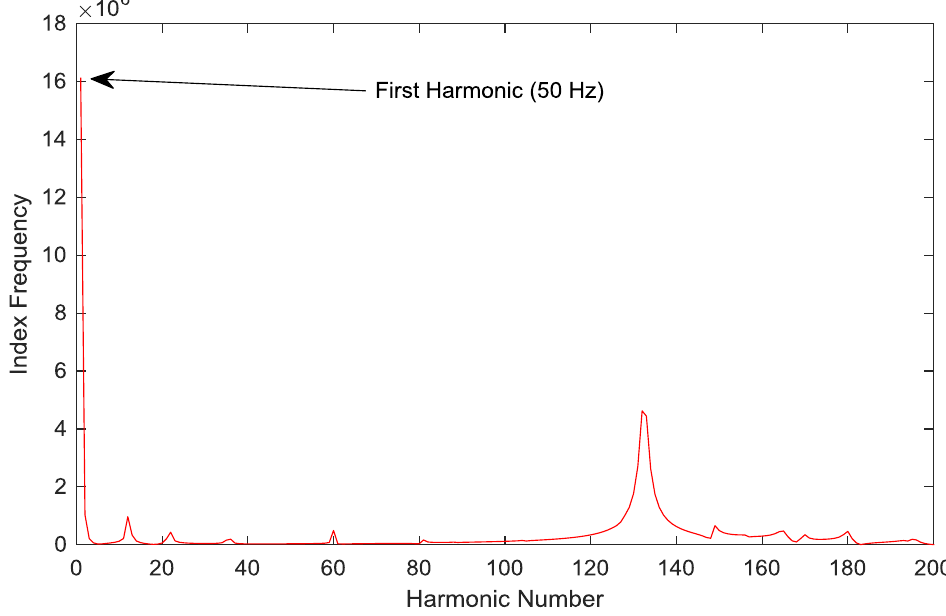
Figure 12. Frequency component waveform of the possible fault in section (3-4).